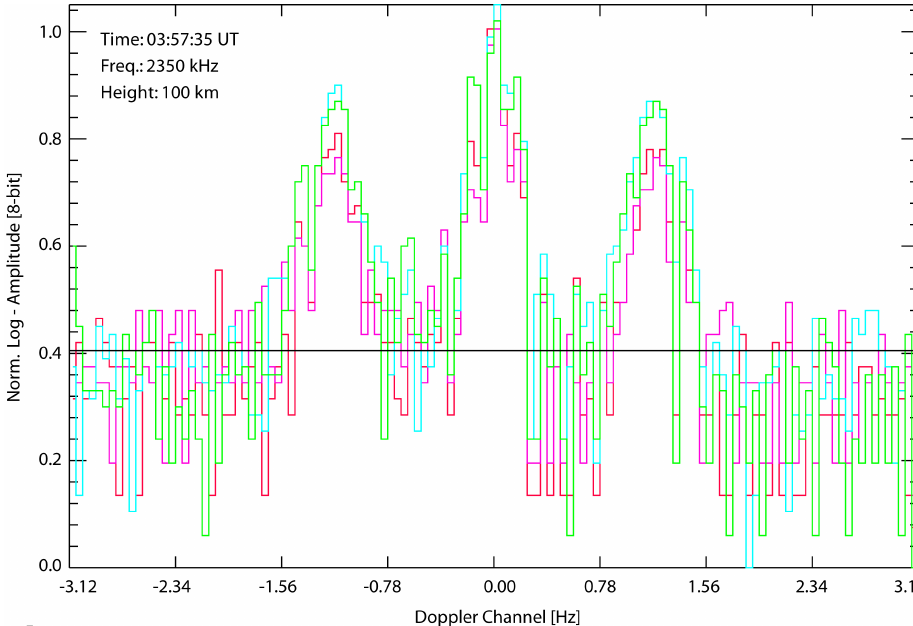
Fig. 7. Superimposed four antenna log-amplitude spectra recorded for a sounding frequency of 2.35MHz and 100km group range recorded at 03:57 UT on 16 December 1996. The thin horizontal line at around 10dB indicates the most probable amplitude. Both the side-peaks and center-peak are well above the noise floor. In this particular instance, only 3 to 4dB separates Bragg backscatter from total reflection echoes.